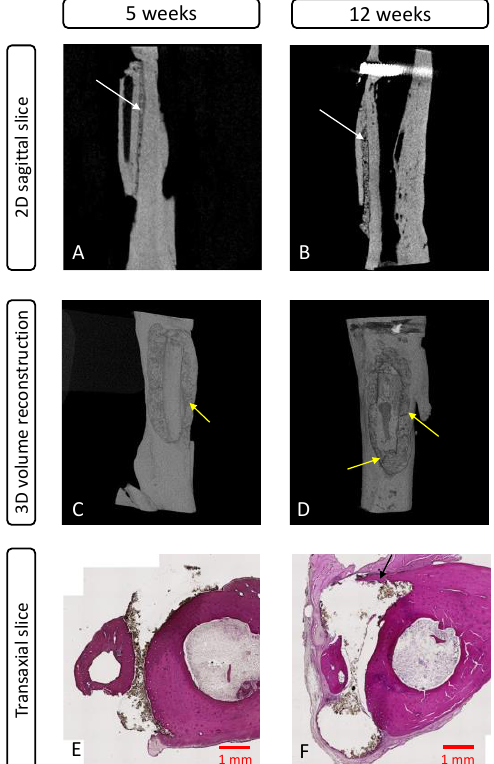
Figure 7. Photographs of in vivo rat model with glued fibula/tibia (autograft fixation) used for evaluating the fixation of the fibular graft with TTCP/OPS-nPDA glue: ( A ) intraoperative photograph showing a fibular autograft glued to a rat tibia with a position indicator (screw); ( B ) photograph of a fibular autograft glued to a rat tibia after 12 weeks, which remained stable and was without secondary displacement.